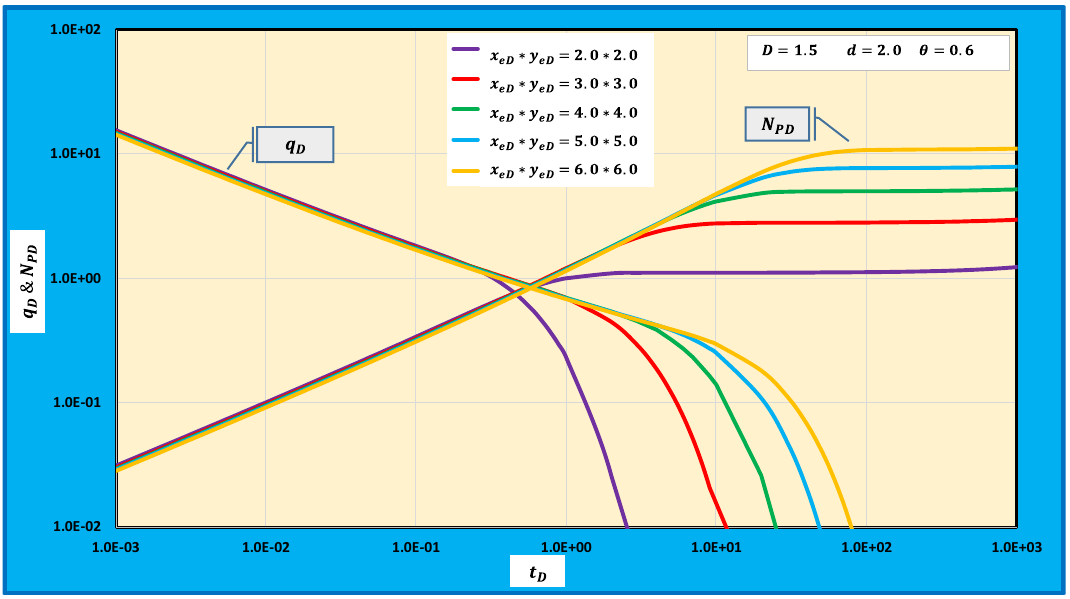
Fig. 15 Flow rate and cumulative production behaviors for different drainage areas ( 𝜃 = 0.6 )